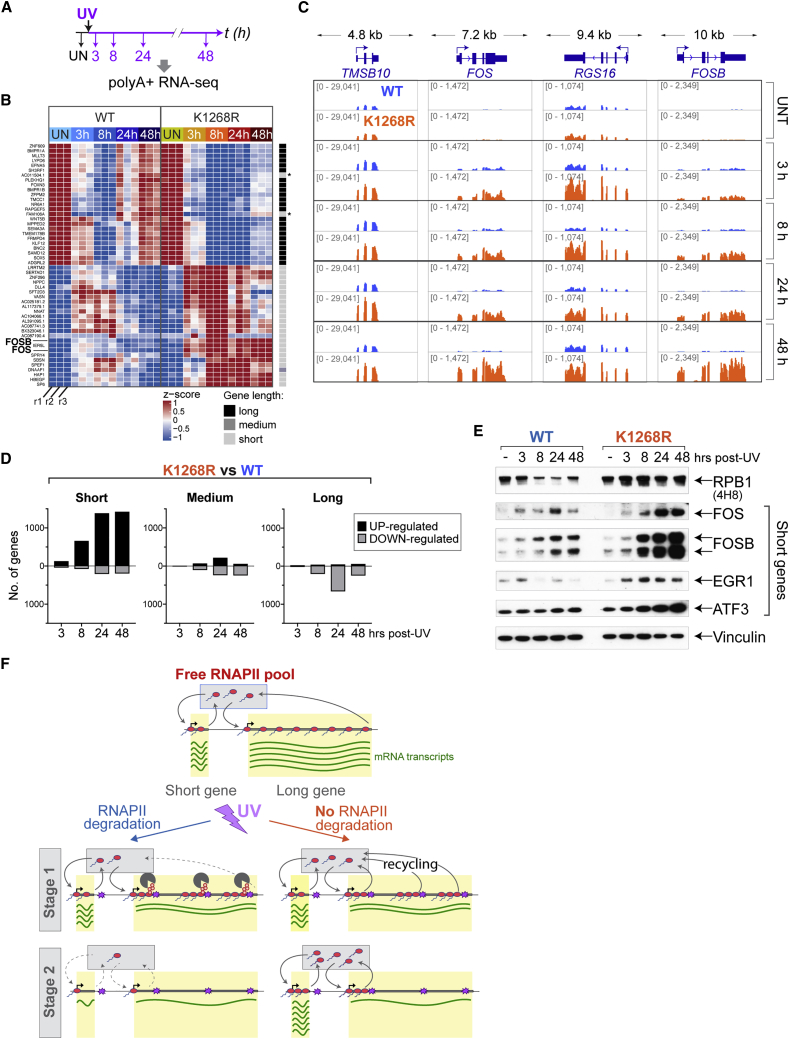
K1268 Ubiquitylation Is Required to Prevent Long-Term Transcriptional Defects upon Acute Exposure to UV(A) Experimental design.(B) Heatmap, showing expression over time, of the top 50 down- and upregulated genes in K1268R cells 8 h after UV irradiation (20 J/m2). Each column within a treatment group represents a biological replicate (r1, r2, r3), and each row represents one gene. Gene lengths are shown on the right, in shades of gray. Asterisks indicate genes mis-annotated as short, but confirmed by manual inspection to be long.(C) Browser tracks from mRNA-seq experiment at four short genes.(D) Bar plots of genes differentially expressed between K1268R and WT cells (logFC >1, false discovery rate [FDR] <0.01), for short, medium, and long genes, at different times after UV irradiation (20 J/m2). Positive side of y axis: upregulated genes; negative side: downregulated genes.(E) Western blot showing proteins encoded by short, immediate-early genes, at different time points after UV irradiation (20 J/m2).(F) Model depicting how DNA damage and RNAPII (red sphere) levels influence transcription and mRNA level (green lines) after UV irradiation, in the first stage (45 min equivalent, middle panel) and second stage (3 h + equivalent, bottom panel) of the transcription shutdown.See also Figure S5.